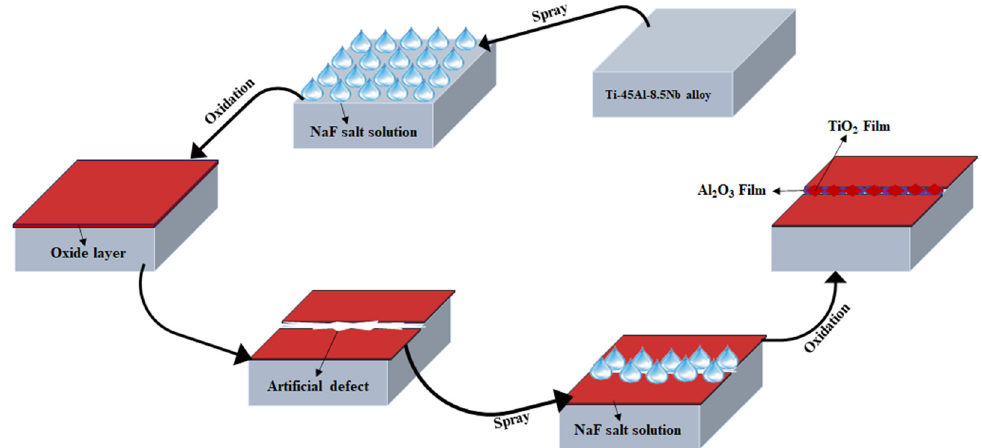
Figure 1. X The diagram of the γ -TiAl alloy specimens treated with NaF-containing aqueous solution.